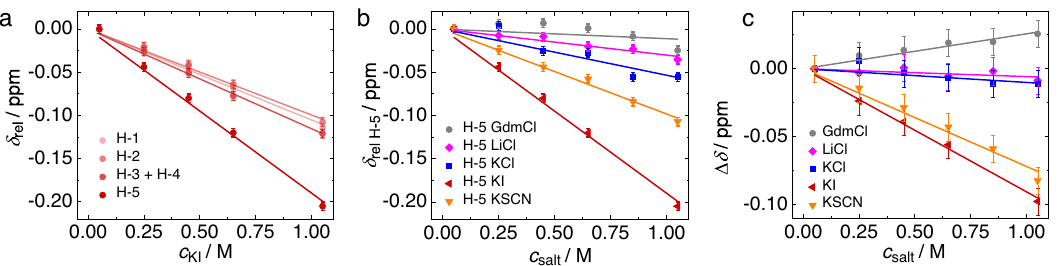
Fig. 5 Salt-induced changes of the chemical shifts of the amide proton (H-5) differ from aliphatic protons H-1 – H-4. a Concentration-dependent relative (cid:1) (cid:3) (cid:1) (cid:3) (cid:2) δ c ¼ 0 : 05M chemical shift, δ rel ¼ δ c salt for aqueous solutions of 250 mM 2Ala with increasing concentration of KI. b Concentration and salt- (cid:1) (cid:3) (cid:1) (cid:3) salt c ¼ 0 : 05M (cid:2) δ dependent relative shift of the NH proton H-5, δ relH (cid:2) 5 ¼ δ H (cid:2) 5 c salt . c Differential chemical shift 4 δ ¼ δ relH (cid:2) 5 (cid:2) δ relH (cid:2) 1 . Symbols H (cid:2) 5 salt show experimental data and error bars are based on the typical experimental reproducibility. Solid lines show linear fi